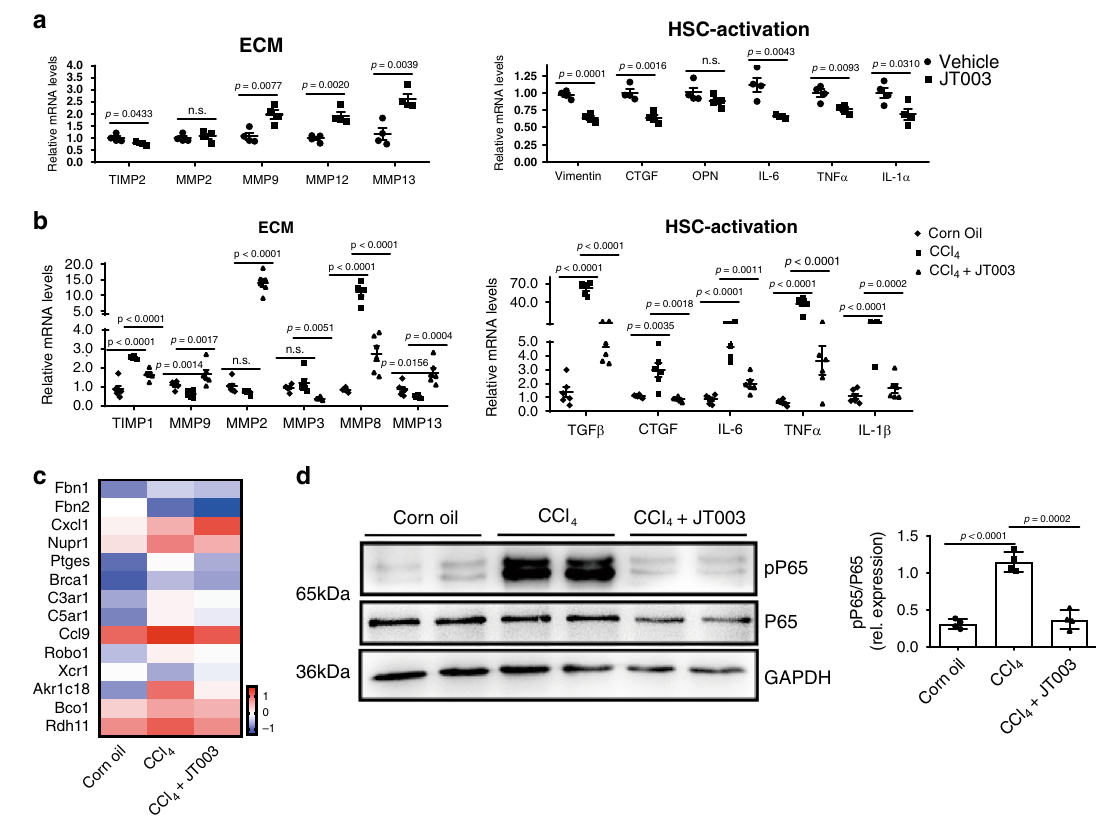
Fig. 6 JT003 suppressed the activation of HSCs in CCl 4 -induced liver fi brosis. a Quantitative RT-PCR assay was performed to determine mRNA transcription of the genes related to ECM accumulation and HSC activation in the indicated groups. b mRNA transcription of the genes related to ECM accumulation and HSC activation in the liver of mice treated with Corn Oil, CCl 4 or CCl 4 plus JT003 therapy. c The HSC activation related genes which were signi fi cantly up-regulated and down-regulated in RNAseq analysis ( q < 0.001). d Western blotting assay of total NF κ B (P65) and phosphorylated NF κ B (pP65) measured in liver samples of mice in the indicated groups. For in vitro experiment, the concentration of JT003 is 200 μ M. For the in vivo experiment, the dose of JT003 is 500 μ g kg − 1 . Here and later, for each assay, three separated experiments were performed. And for each experiment ( n = 4 cell samples/group or n = 6 mice/group). For the in vivo experiment, the dose of JT003 is 500 μ g kg − 1 . All the above data are presented as mean values ± SEM using unpaired Student ’ s t test. Source data are provided as a Source Data fi Hemolytic activity assay . The hemolytic activity of candidate peptides was assessed with mouse red blood cells 52 . Candidate peptides were incubated with mouse red blood cells (4% hematocrit in PBS) in indicated concentrations (2, 4, 8, 16, 32, 64, 128, 256, 512, 1,024, 2,048, 4,096 μ M) at 37 °C for 1 h. Centrifugation for 10min at 1000 xg to isolate the supernatants, the absorbance was determined at 490 nm. PBS was used as the positive control and 0.2% Triton X-100 which could cause 100% hemolysis was used as the negative control.